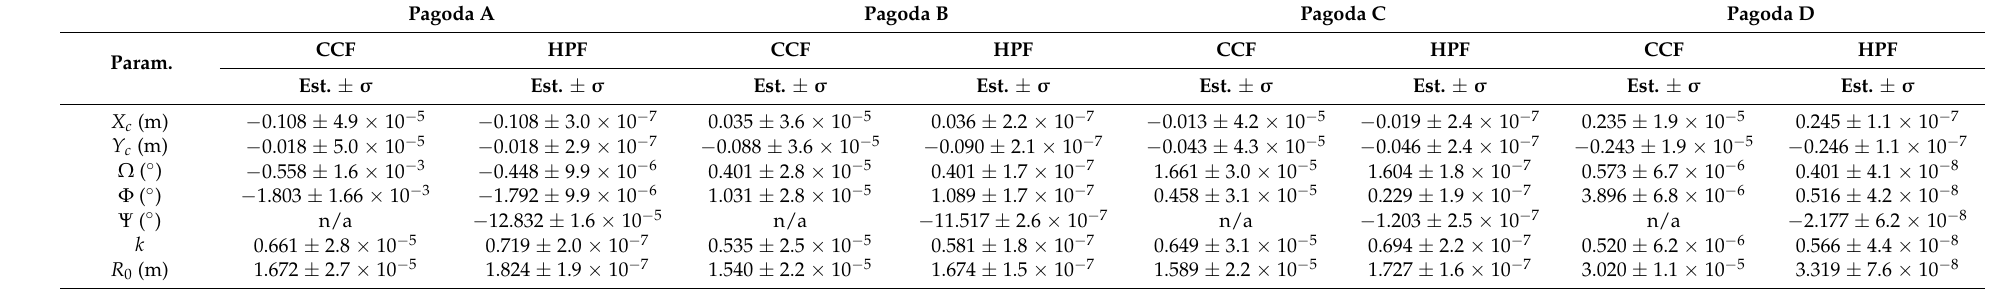
Table 2. Estimated parameters and their precisions of the circular cone/cylinder fitting (CCF) and the hexagonal pyramid/prism fitting (HPF) for Part 1.